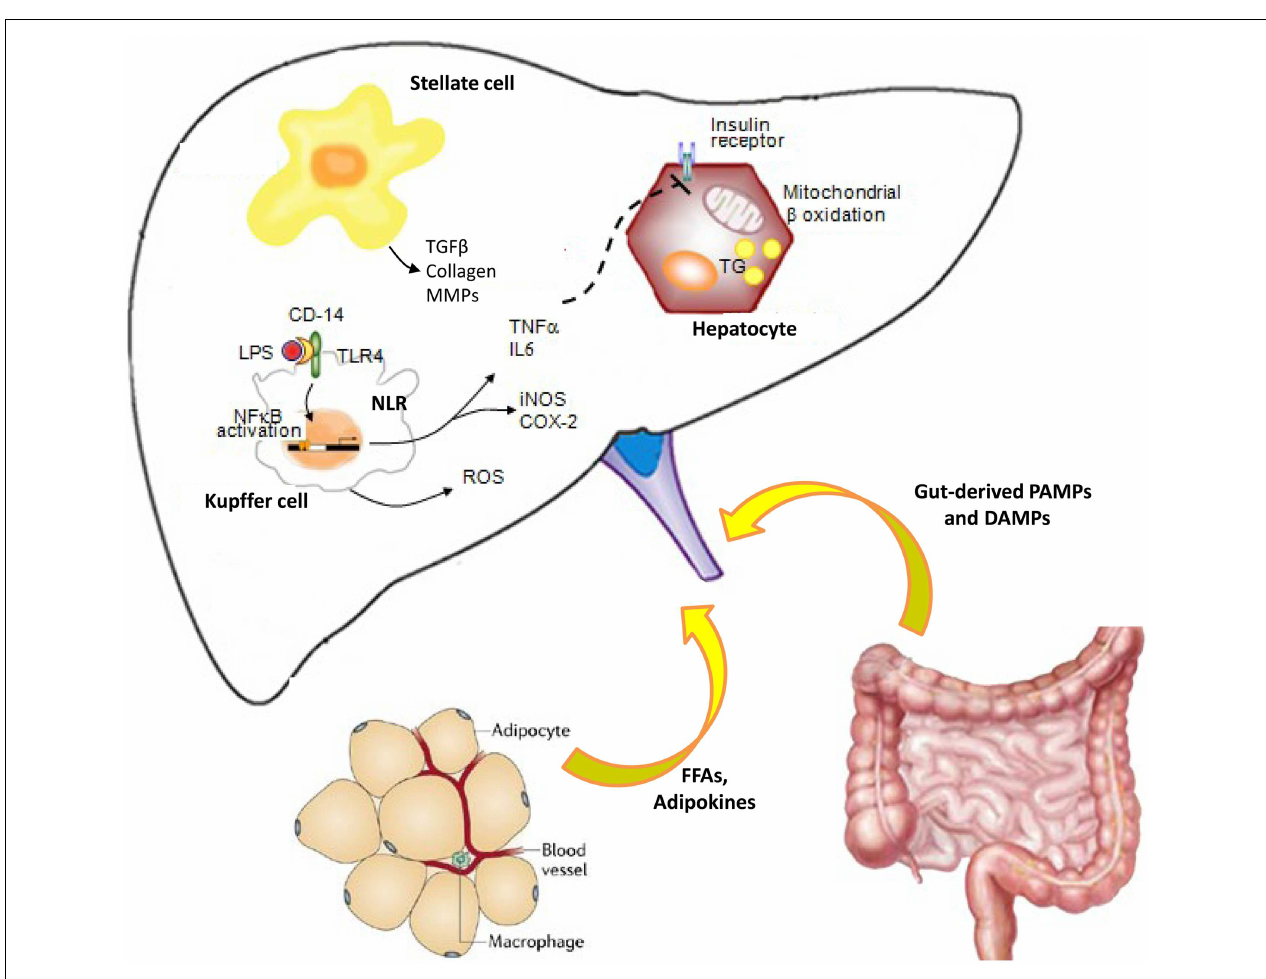
endotoxin levels during chronic liver disease, worsening inflammation, and inducing fibrogenesis viaToll-like receptor (TLR) signaling. Kupffer cells are hit by bacterial or insults and contribute to the cytokine production and hepatic stellate cell activation to maintain the balance between inflammatory and fibrogenic signaling. Adipokines secreted from adipose tissue and inflammatory cytokines impaired hepatic insulin signaling, leading to insulin resistance. All these events lead to a vicious cycle that causes worsening of liver damage, further inflammation, and disease